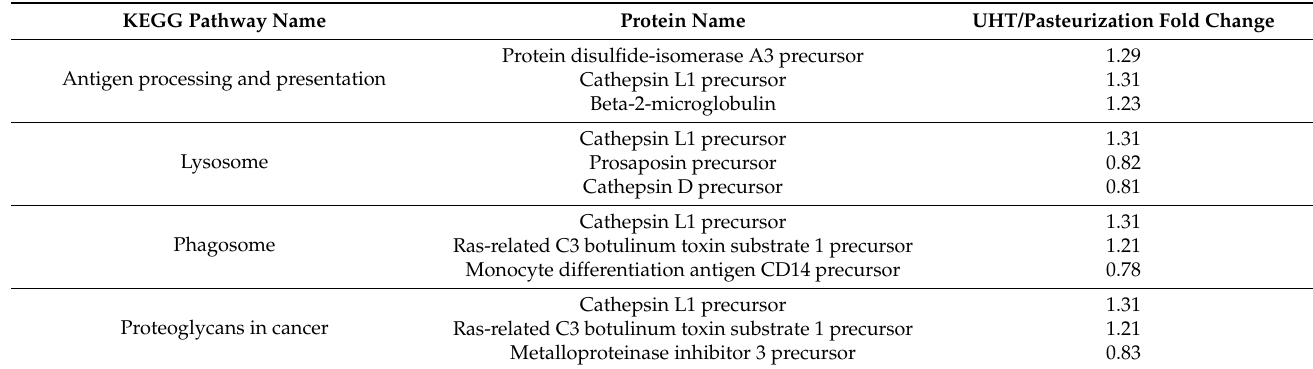
Table 1. Up-regulated and down-regulated proteins identified by KEGG enrichment analysis after UHT thermal treatment.